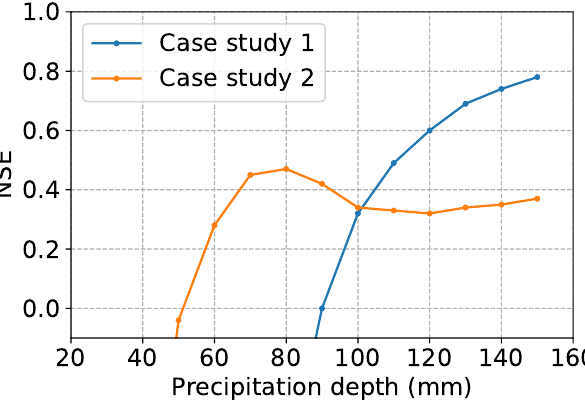
Figure 15. NSE values for the simulation results of the two case